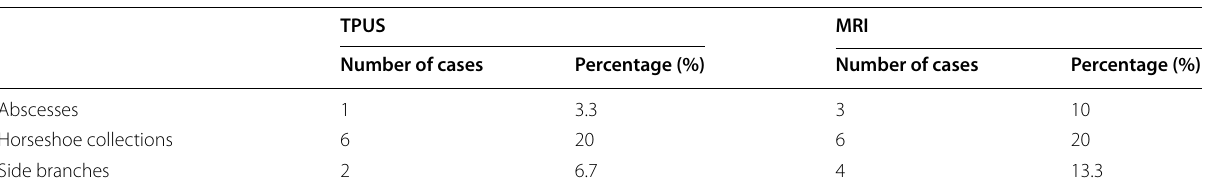
Table 3 Findings of TPUS in relation to pelvic MRI a Findings of TPUS with MRI regarding the presence of abscesses, horseshoe collections and side